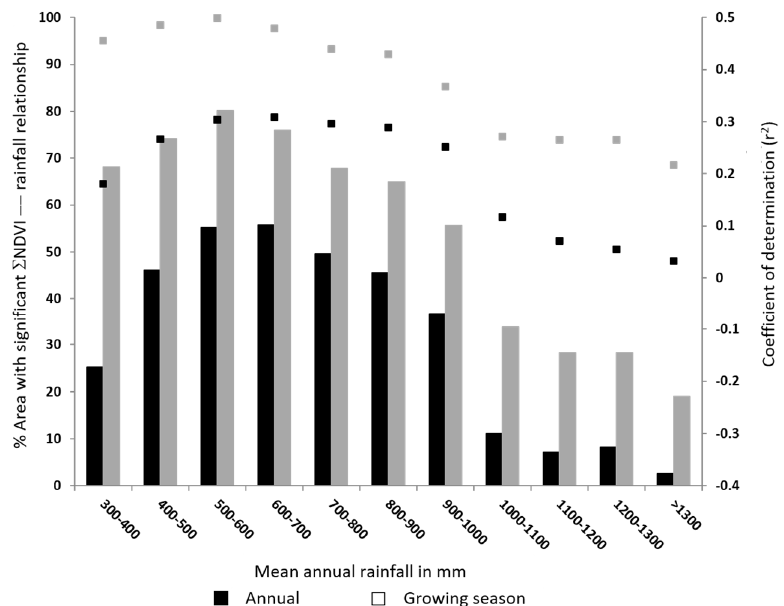
Figure 5. Percentage area with significant Σ NDVI-rainfall relationships (bars) in each rainfall range and the spatial average of the coefficient of determination (r 2 ) values (points) of all pixels within each rainfall range.